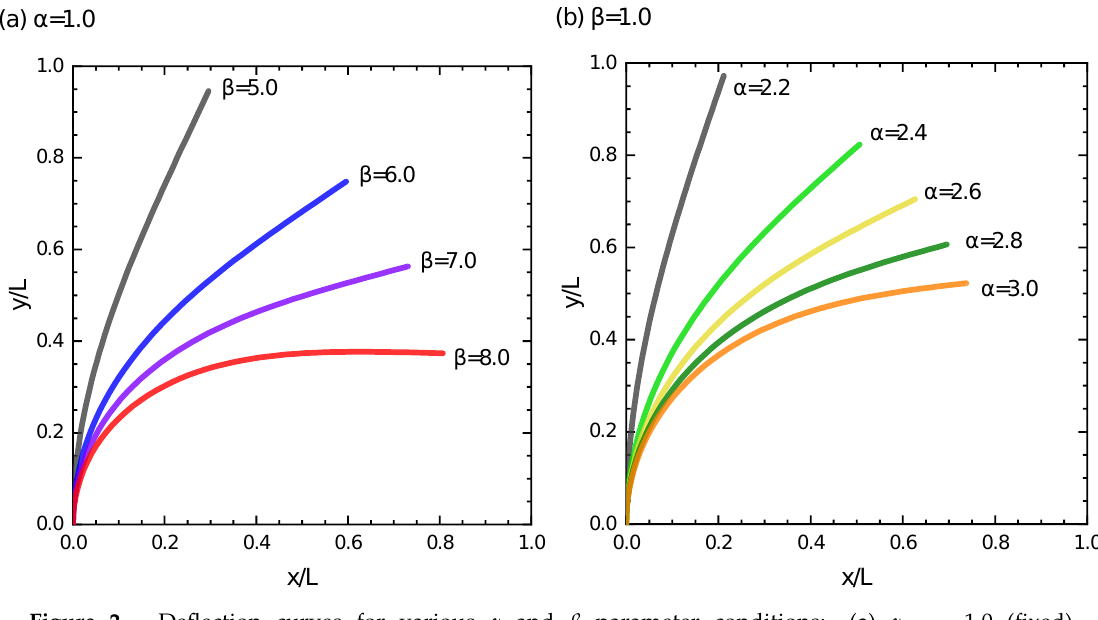
Figure 2. Deflection curves for various α and β parameter conditions: ( a ) α = 1.0 (fixed) and ( b ) β = 1.0